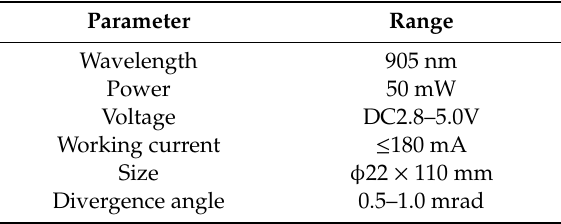
Table 2. Main parameters of the